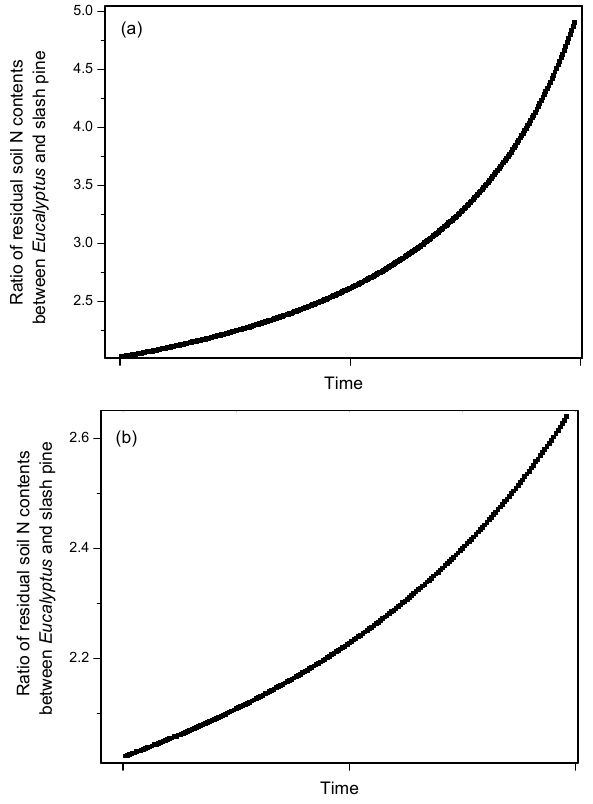
Figure 6. Ratios of residual soil N contents between Eucalyptus and slash pine for N -acetylglucosaminidase (a) and leucine aminopep- tidase (b) across